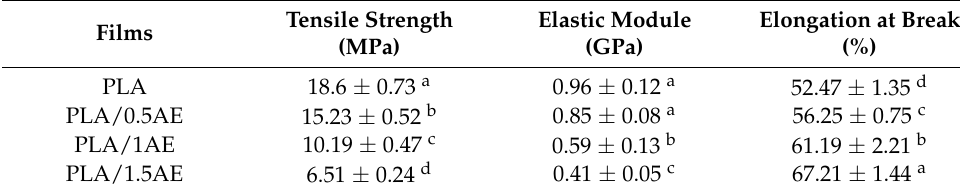
Table 3. Mechanical properties of poly lactic acid (PLA) films incorporated with anise essential oil (AE) 1